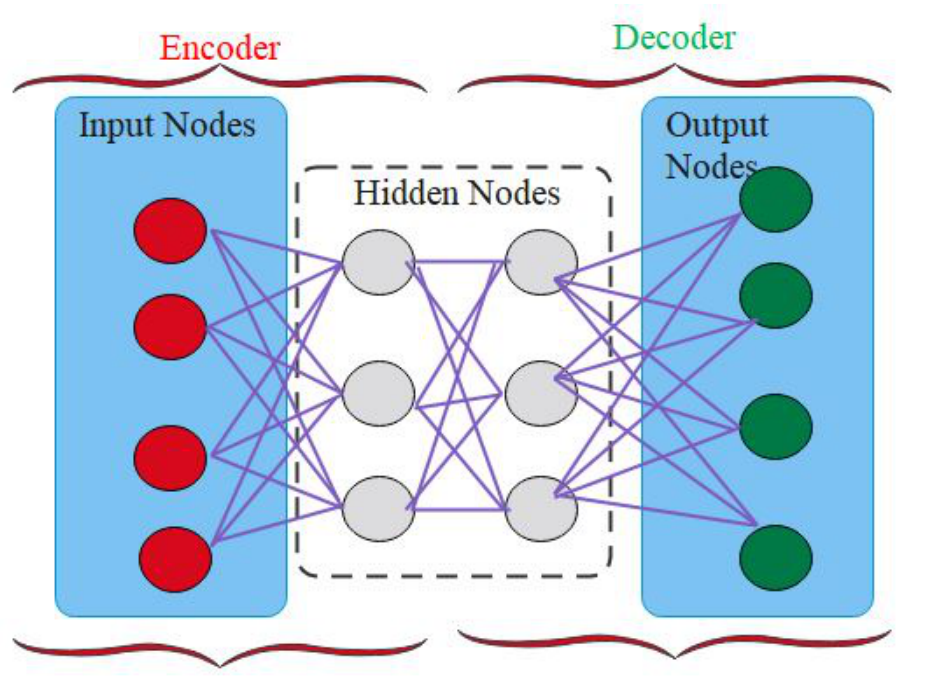
Figure 7. Architecturee of Auto-Encoder Model. Table 5. RBM model in IoT